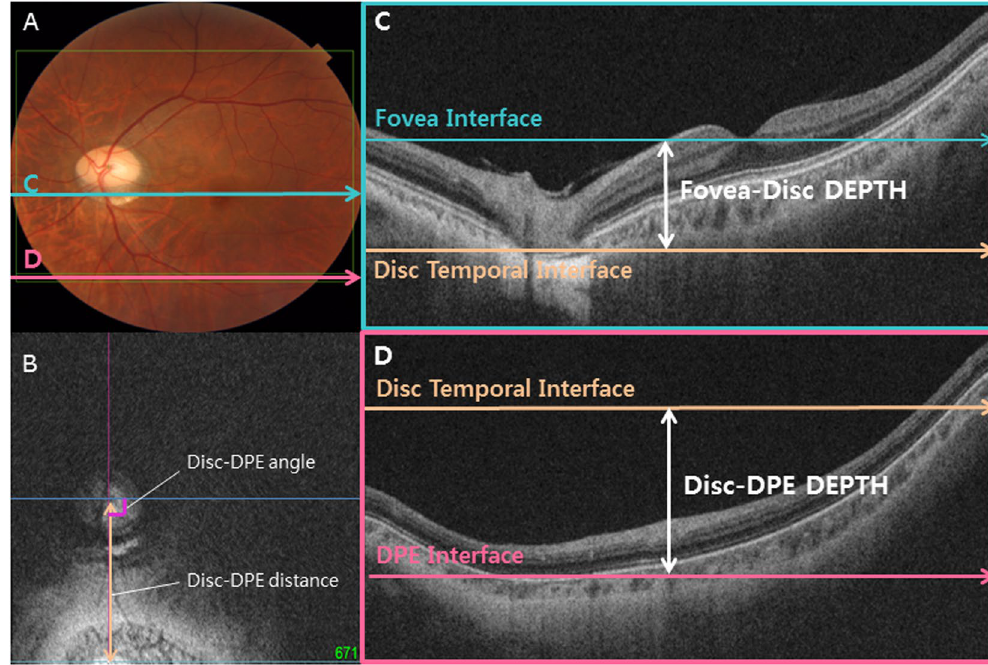
Figure 3. Measurement of the main outcome measures. ( A ) A common fundus photograph of a subject with tilted disc syndrome. ( B ) Coronal section reveals the DPE at the inferior globe. The Disc-DPE distance was defined as the straight-line distance between the center of the optic disc to the center of the DPE measured along the same coronal plane as the DPE. The Disc-DPE angle was defined as the angle between the horizontal meridian crossing the OCT-defined center of the optic disc and the straight line from the OCT-defined center of the optic disc to the DPE. ( C ) A Horizontal section C in section A. The Fovea-Disc depth was the depth between the interface of the fovea and the interface of temporal border of the optic disc. ( D ) A Horizontal section D in section A. The Disc-DPE depth was the depth between the interface of the DPE and the interface of temporal border of the optic